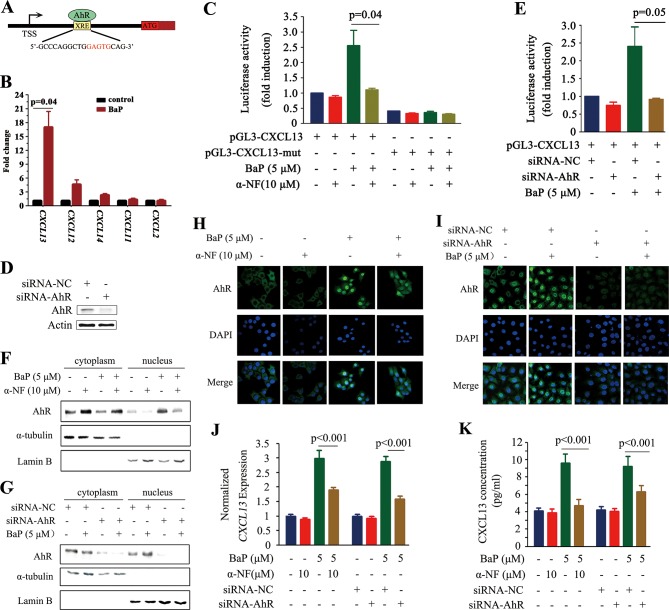
CXCL13 is a target gene of aryl hydrocarbon receptor (AhR).(A) The AhR binding site is located at 1.7 kb downstream of the CXCL13 transcription start site (TSS). (B) A chromatin immunoprecipitation (ChIP) assay was performed in BaP-treated or untreated 16HBE cells. The enriched CXCL13 was detected by qPCR. (C) The A549 cells were transfected with the wild-type (WT) or mutant (deletion mutation (mut) in the XRE-like sequence) CXCL13 promoter-luciferase reporter construct, treated with BaP and/or α-NF for 48 hr, and assessed by the luciferase assays. (D, E) A549 cells were transfected with AhR-specific siRNAs, and western blot was performed to detect the expression of AhR. Three siRNAs were used, and the result of one was shown (D). Luciferase assays were performed in A549 cells transfected with the WT CXCL13 promoter-luciferase reporter construct and siRNAs in the absence or presence of BaP (E). (F, G) Western blot analyses of AhR in the cytoplasm and nucleus of 16HBE cells co-incubated with BaP, with or without α-NF treatment (F) or siRNA transfections (G). (H, I) Immunofluorescence assays of AhR expression in 16HBE cells co-incubated with BaP, with or without α-NF treatment (H) or siRNA transfections (I). (J, K) CXCL13 mRNA (detected by qPCR; J) and protein (in supernatants of the cells detected by ELISA; K) levels in the AhR-silenced 16HBE cells treated with BaP and/or α-NF.